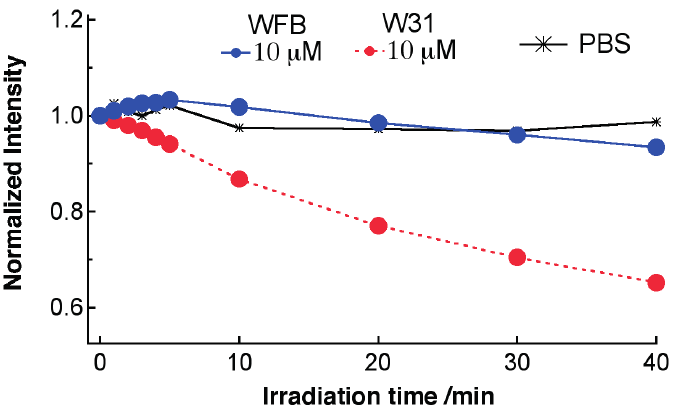
Figure 8. Time dependence of fluorescence spectra of Na-Ph-a in WFB ( left ) and W31 ( right ) cells with irradiation of 405-nm light in air. The irradiation times were 0, 1, 2, 3, 4, 5, 10, 20, 30 and 40 min. The concentration of Na-Ph-a in the culture solution was 10 μ